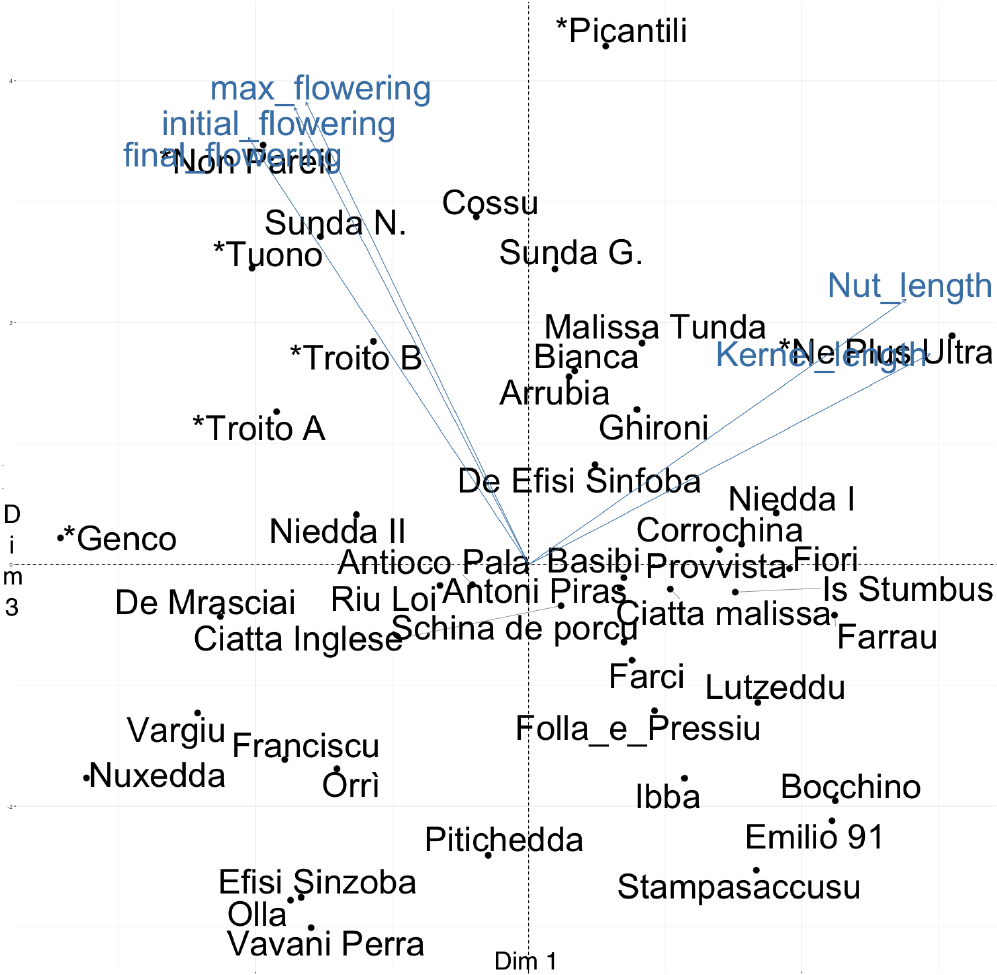
Figure 2. Biplots of individuals and variables in the PCA components 1 and 3. Only the five variables giving the highest contributions are shown. The names of reference cultivars are preceeded by an